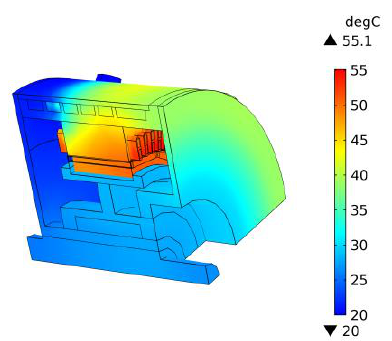
Figure 14. Three-field simulation without considering the fluid-heat coupling factors.